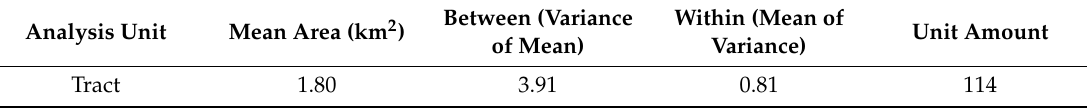
Figure 5. Distributions of nightlight gradients in Cincinnati and details in/around CBD. Table 2. Nightlight Gradients in Cincinnati.